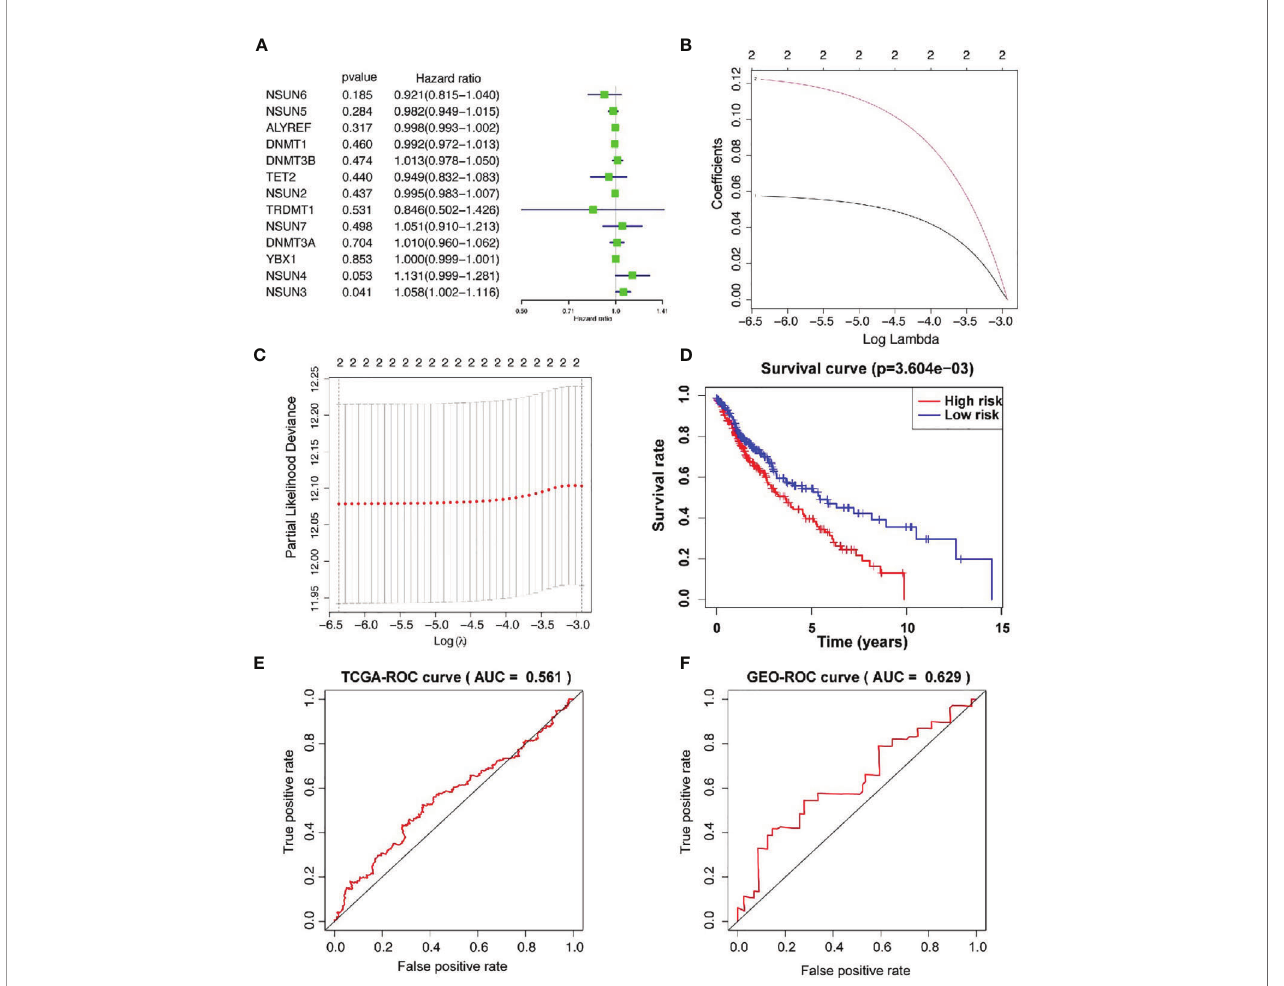
FIGURE 2 | Prognostic risk model construction. (A) Univariate Cox regression analysis indicates that DNMT3B , NSUN7 , DNMT3A , NSUN3 , and NSUN4 are the risk genes for LUSC with the hazard ratio (HR) >1. (B, C) The coef fi cients of genes are obtained using least absolute shrinkage and selection operator (LASSO) algorithm. Ten-fold cross-validation used for tuning parameter selection in the LASSO model (D) Kaplan – Meier curves of OS between the high risk and low risk groups. (E) The 3-year receiver operating characteristic (ROC) curves of the training cohort. (F) The 3-year receiver operating characteristic (ROC) curves of the validation cohort. AUC, area under ROC